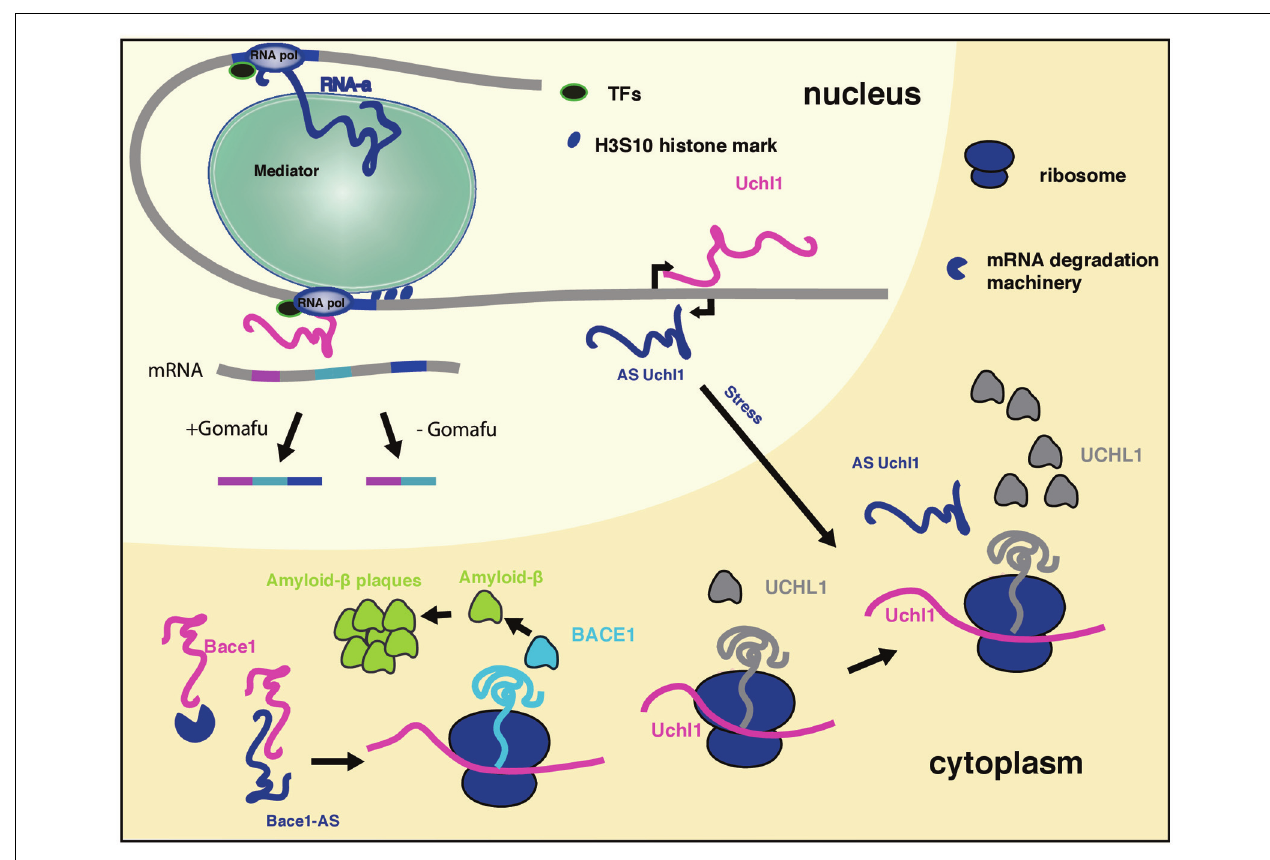
FIGURE 1 |The mechanism of long ncRNAs involved in neurological disorders. Long ncRNAs can regulate every level of gene expression. Shown is a summary of selected long ncRNA functions discussed in